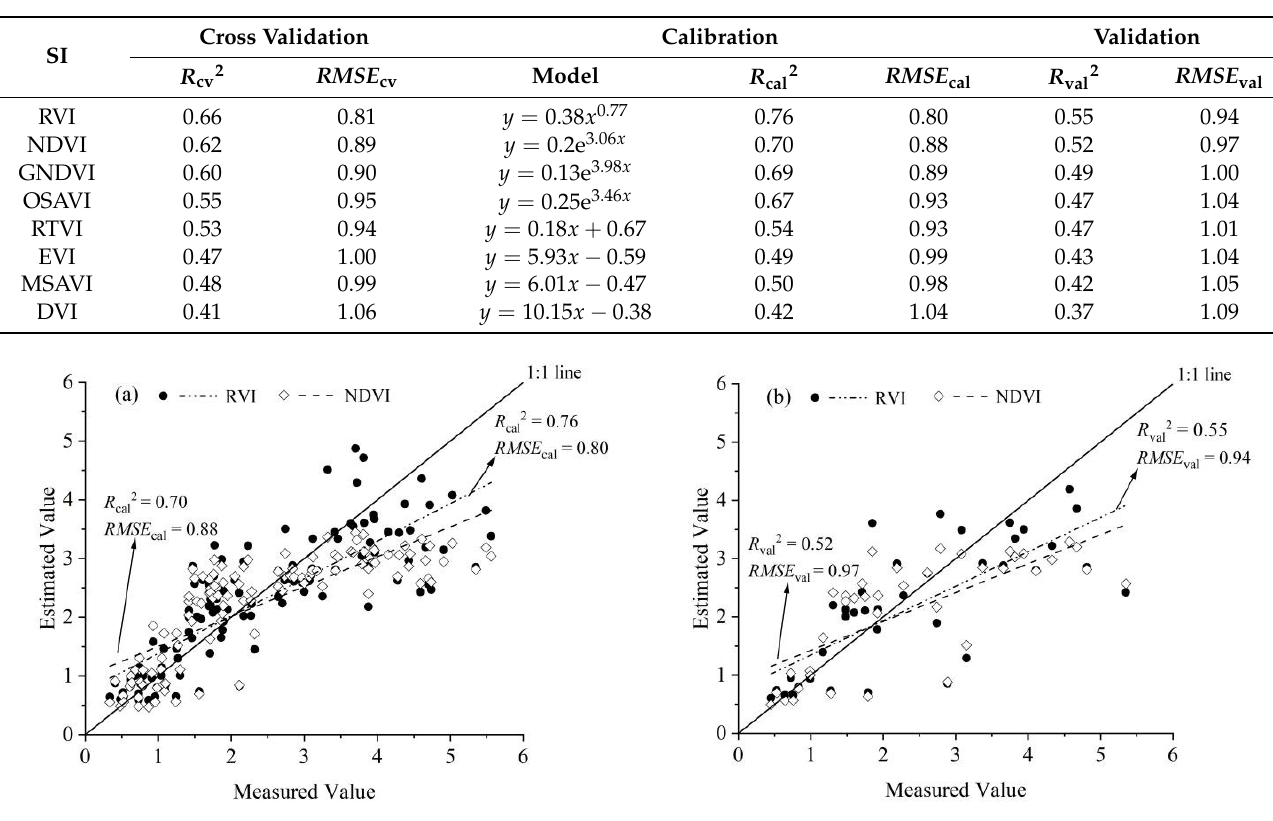
Table 4. LAI prediction results for the models designed using different spectral indices. Linear, logarithmic, exponential, and power models were used for fitting each index. The model type with the highest R cv2 and lowest RMSE cv was used, and the calibration and validation results are expressed in the table.